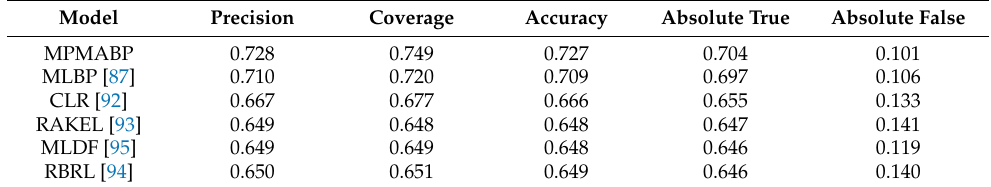
Table 3. The independent test